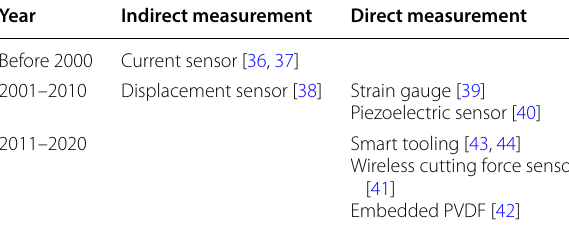
Table 1 Evolution of cutting force measurement